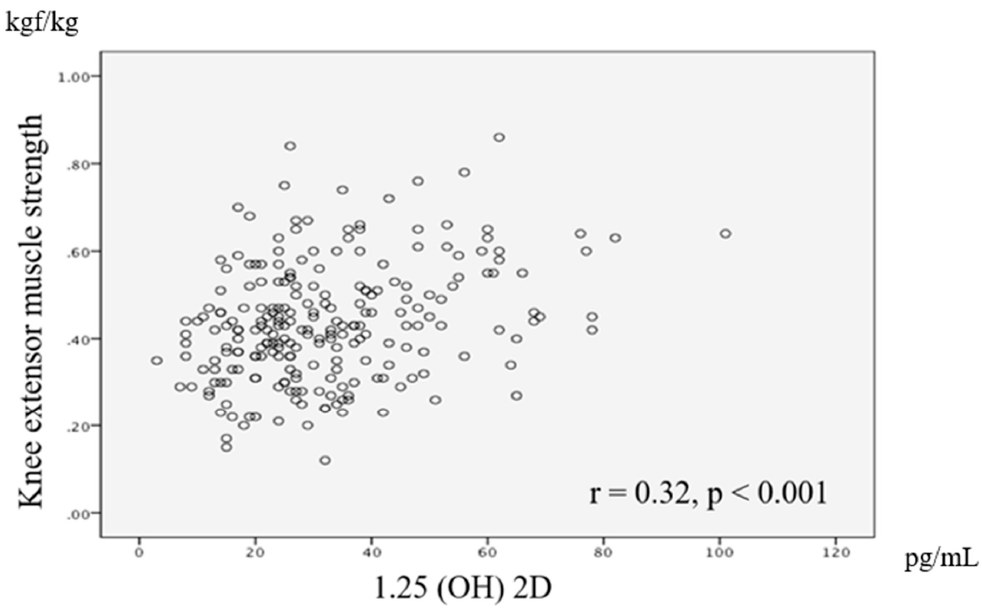
Figure 1. The relationship between knee extensor muscle strength and active vitamin D (calcitriol, or 1.25 (OH) 2 D) using the Spearman rank correlation coe ffi cient. There was a significant positive correlation between leg strength and 1.25 (OH) 2 D ( r = 0.32, p <